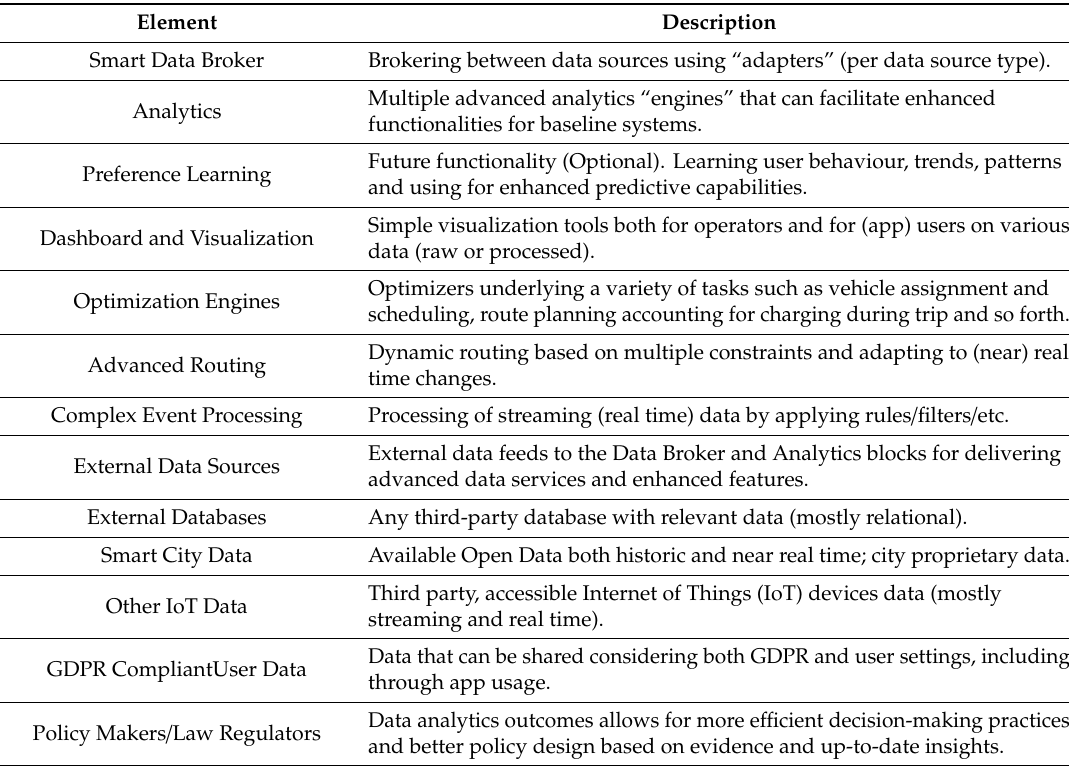
Table 4. Elements of the Data & Analytics Extension block in the eMaaS system